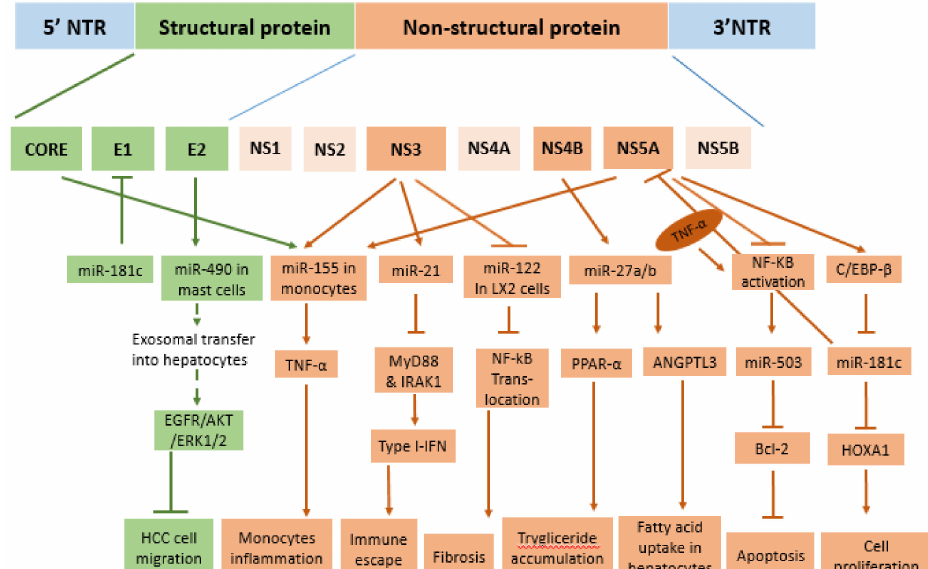
Figure 2. MiRNAs regulated by envelope and non-structural proteins in host cells. E2 proteins induce the release of exosomal miR-490 from mast cells and its internalization by hepatocytes reduced cell migration. NS3 proteins, by modulating miR-155, miR-21, and miR-122, determine inflammation, immune escape, and fibrosis. NS4B, through the modulation of miR-27a and b, affects the lipid metabolism. NS5A inhibits the expression of two oncosuppressor miRNAs, miR-503 and